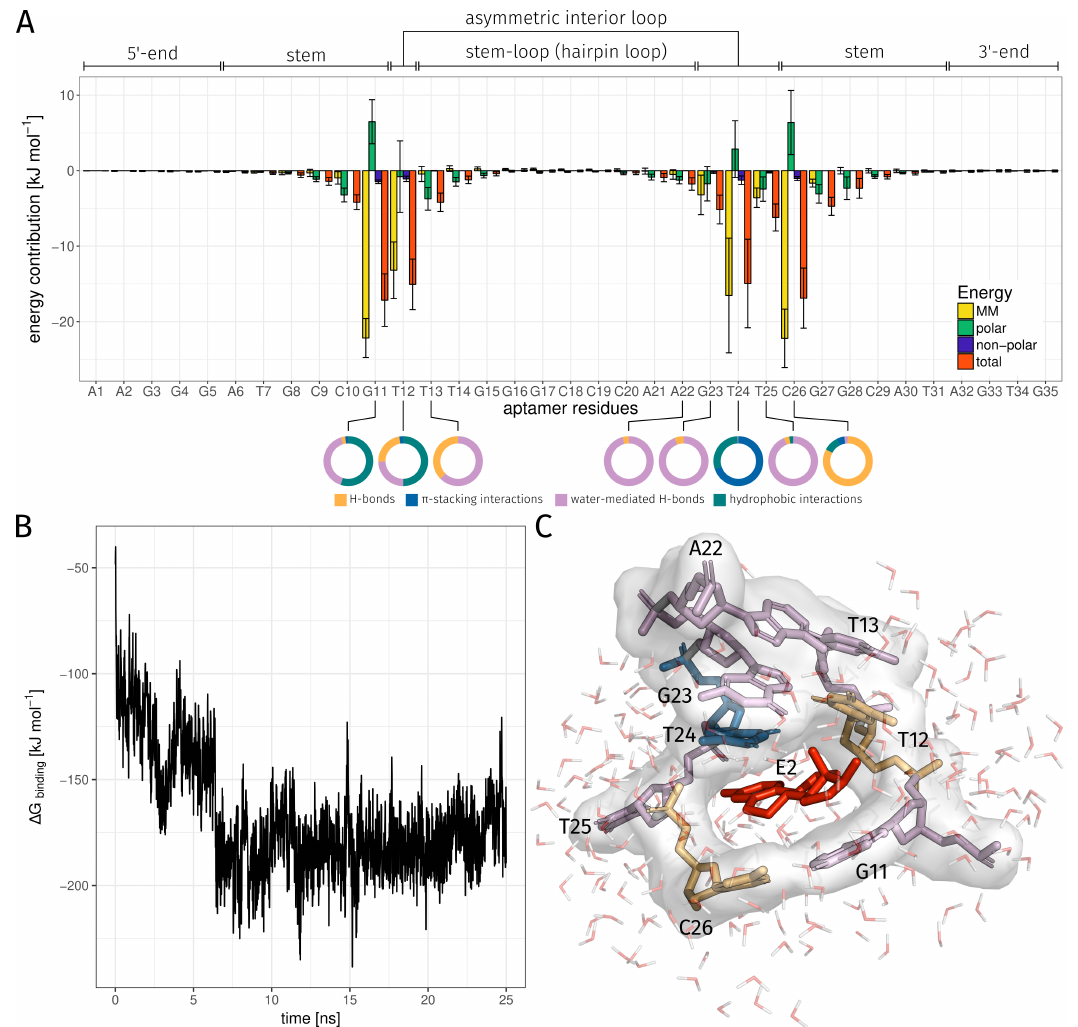
Figure 6. ( A ) Contribution of the aptamer bases to free energy. The various secondary structures of the E2-specific aptamer are shown above the plot. Small donut charts below the energy contribution plot show the distribution of different interactions of the bases interacting with E2. ( B ) Binding energy ∆ G analyses versus time for E2AptC. ( C ) Structural overview of all detected E2 binding bases. The color of binding bases corresponds to the color of the main specific interaction that was formed with E2. The bases T12 and T25 mainly formed H-bonds, the base T24 π -stacking interactions, and the other bases water-mediated H-bonds to E2. E2AptC, E2-aptamer complex; E2, 17 β -estradiol is depicted as stick model in red; H-bonds, hydrogen